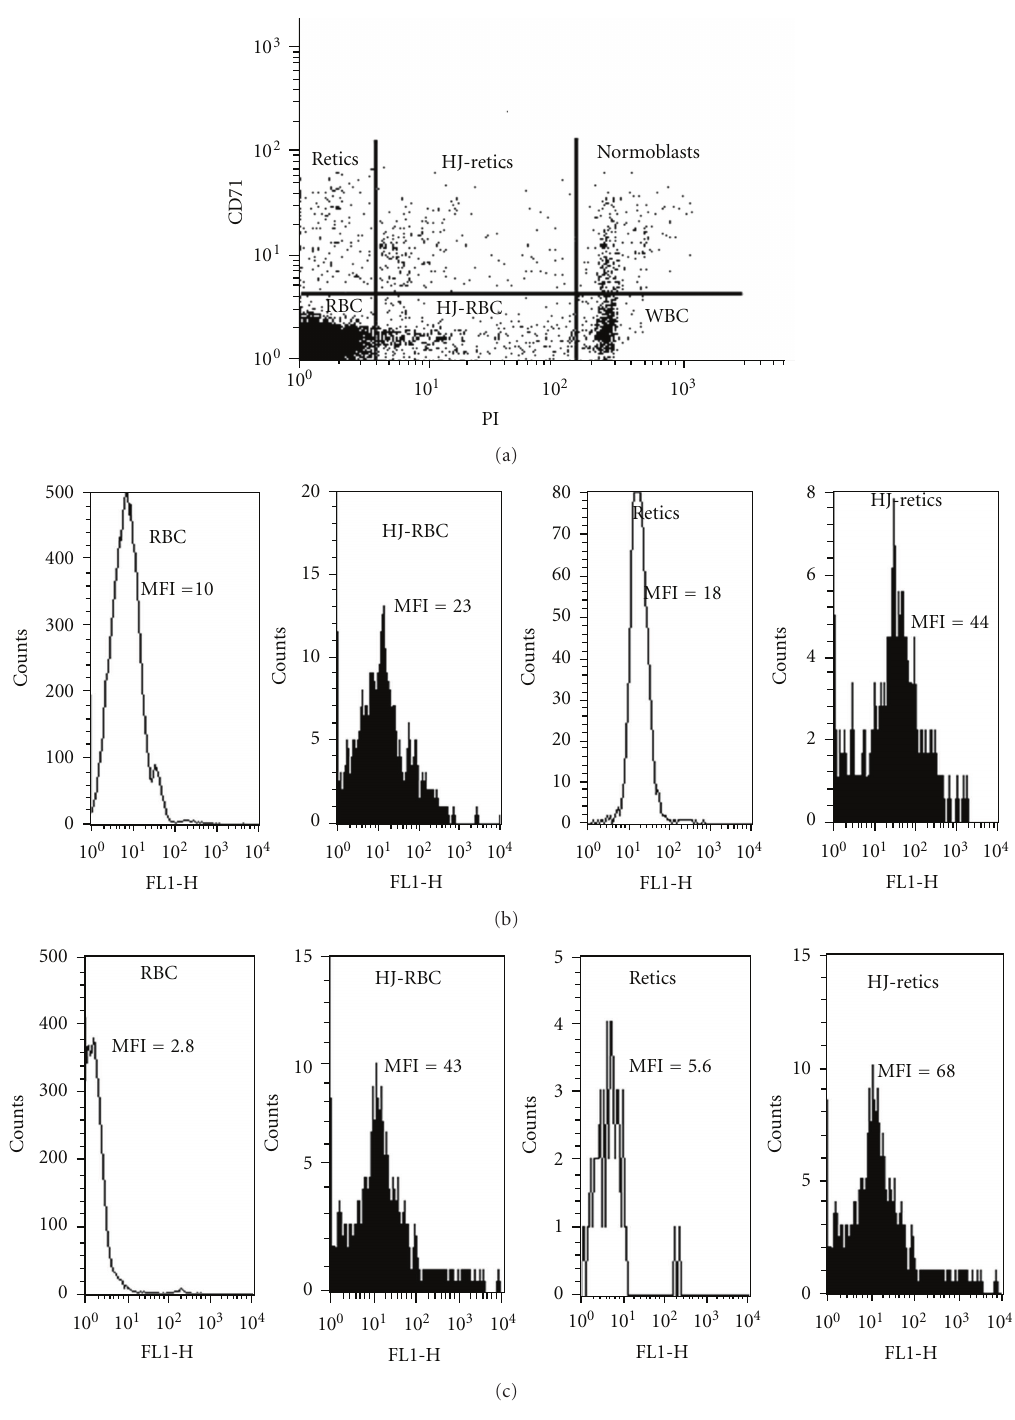
Figure 1: Flow cytometry analysis of ROS and PS in blood cells. Blood cells from a splenectomized β -thalassemic patient were simultaneously stained with an anti-CD71 antibody and propidium iodide (PI), and either DCF for measurement of ROS or annexin-V for measurement of external PS. (a) A CD71 versus PI dot-plot identifying cells as RBCs (CD71-PI-), HJ-RBCs (CD71-PI+), WBCs (CD71-PI++), retics (CD71+PI-), HJ-retics (CD71+PI+), and normoblasts (CD71+PI++). ((b)-(c)) Fluorescence distribution histograms of each cell population with respect to ROS (b) and PS (c). The results expressed as the mean fluorescence index (MFI) are presented for each cell